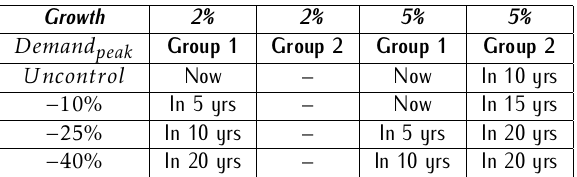
Table 7. Feeder reinforcement plans with controllable loads